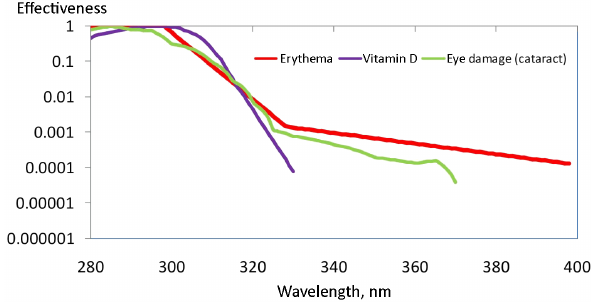
Figure 1. Action spectra for erythema (Diffey et al., 1998), vitamin D (Bouillon et al., 2006) and for eye damage (cataract) (Oriowo et al., 2001)